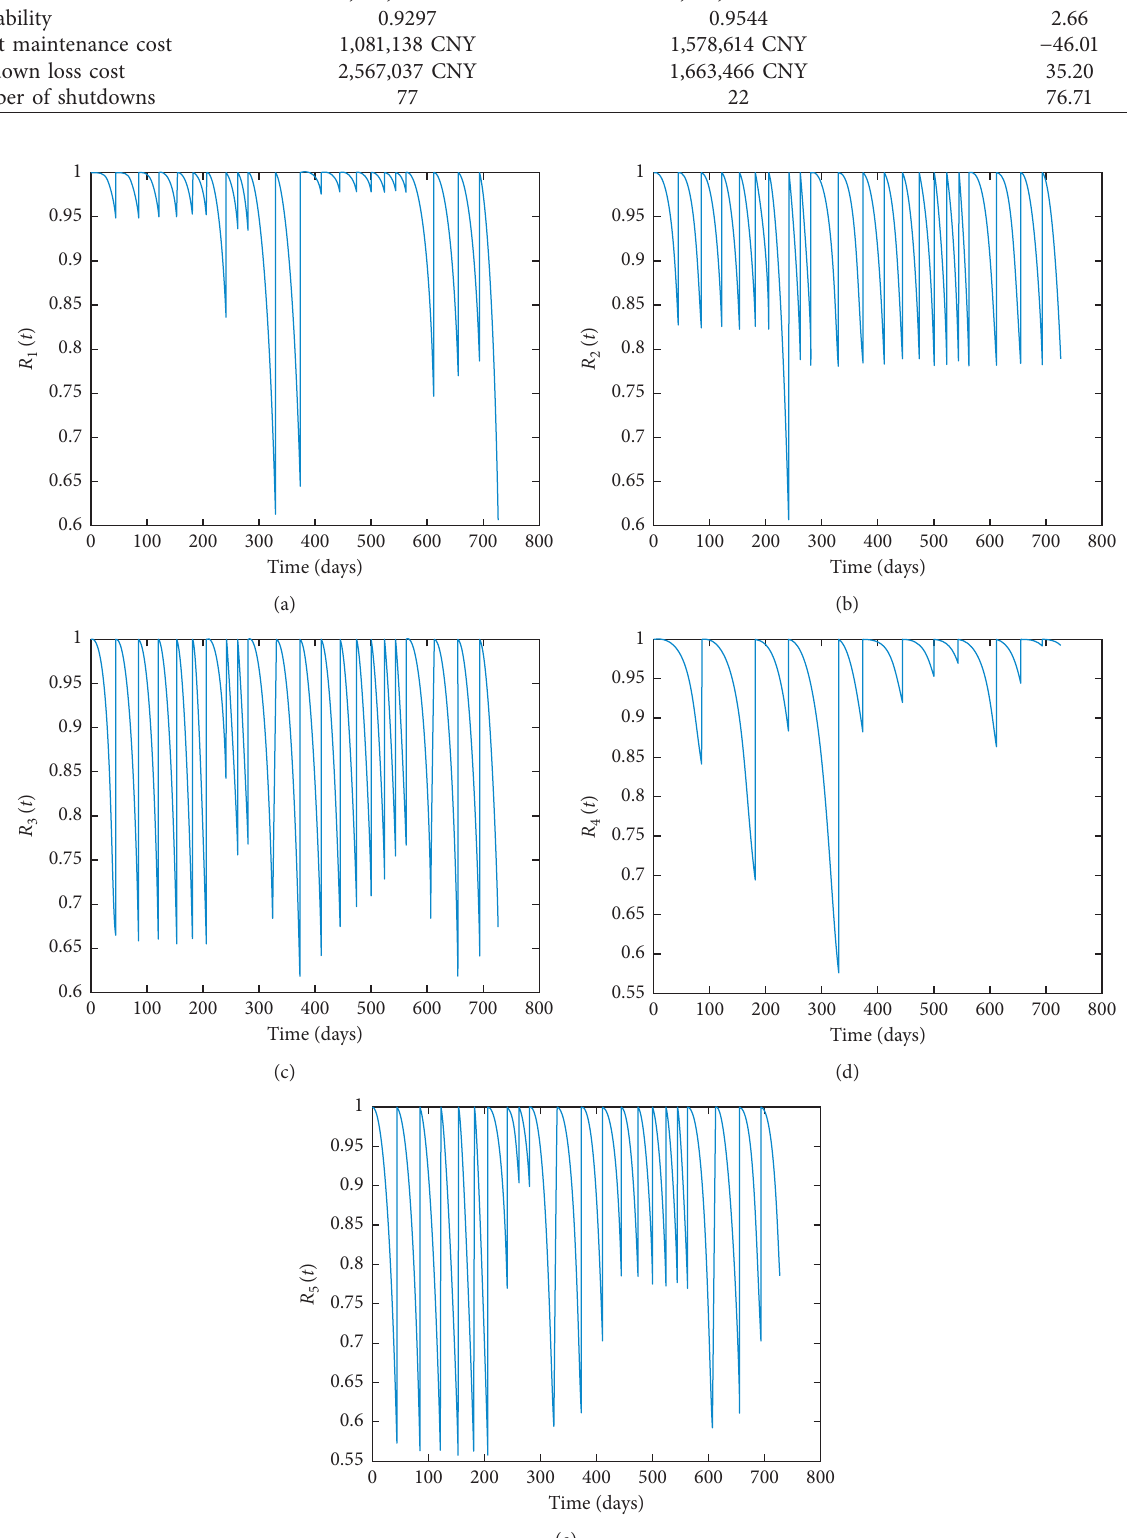
Figure 12: The chart of the component reliability varying with the operating